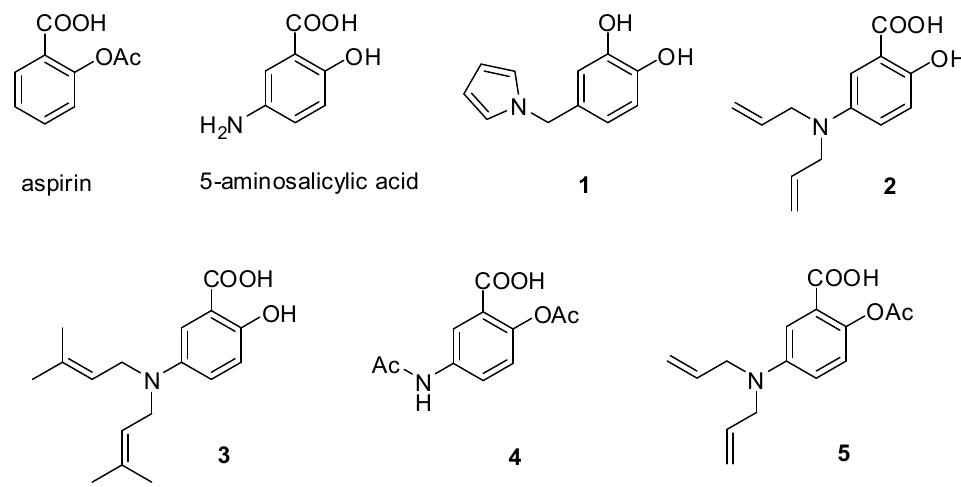
Figure 1. Structures of aspirin, 5-aminosalicylic acid, and synthetic analogues ( 1 – 5 ).